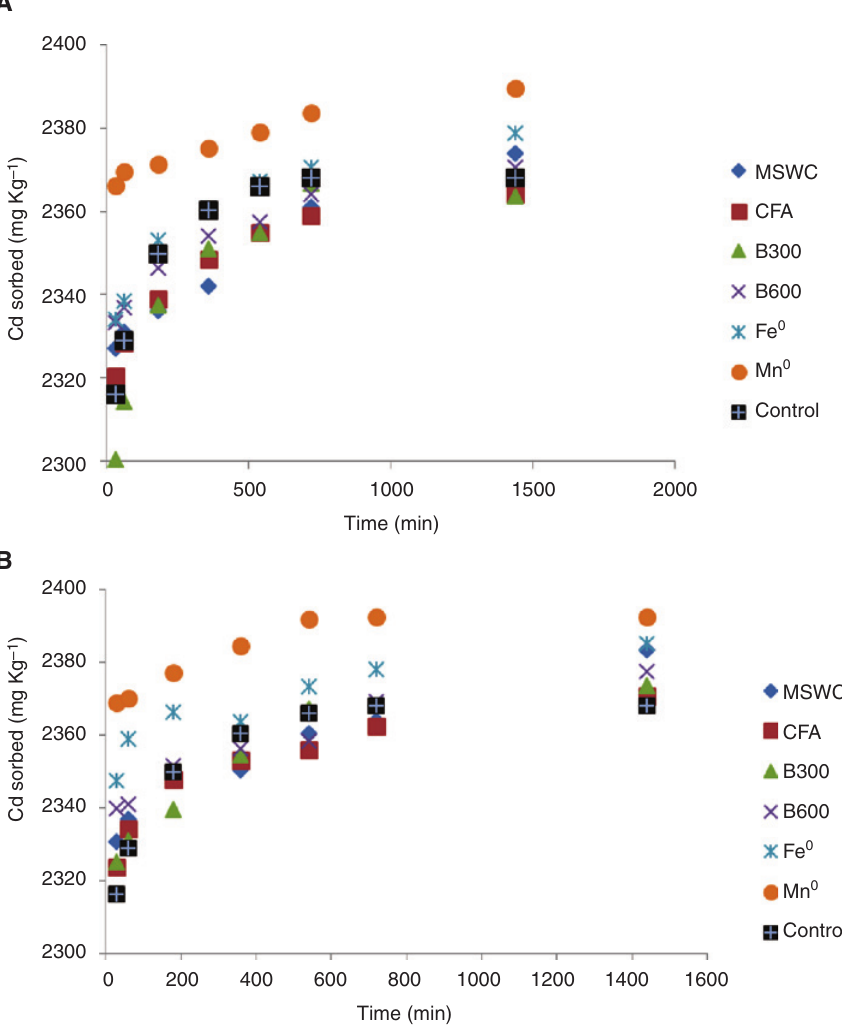
Figure 3: Sorption kinetic Cd in amended soils at the rates of (A) 2% and (B) 5% (amendment level W/W) of amendment